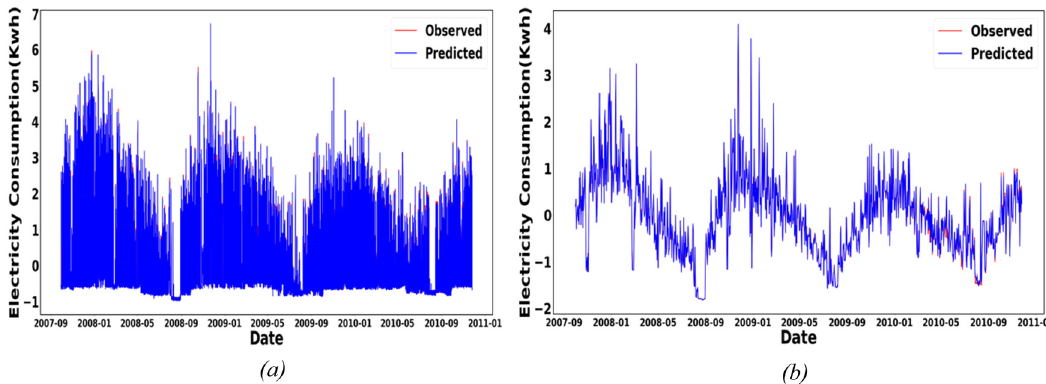
Figure 15: Household predictions vs original observations after feature standardization: ( a ) hourly granularity and ( b ) daily